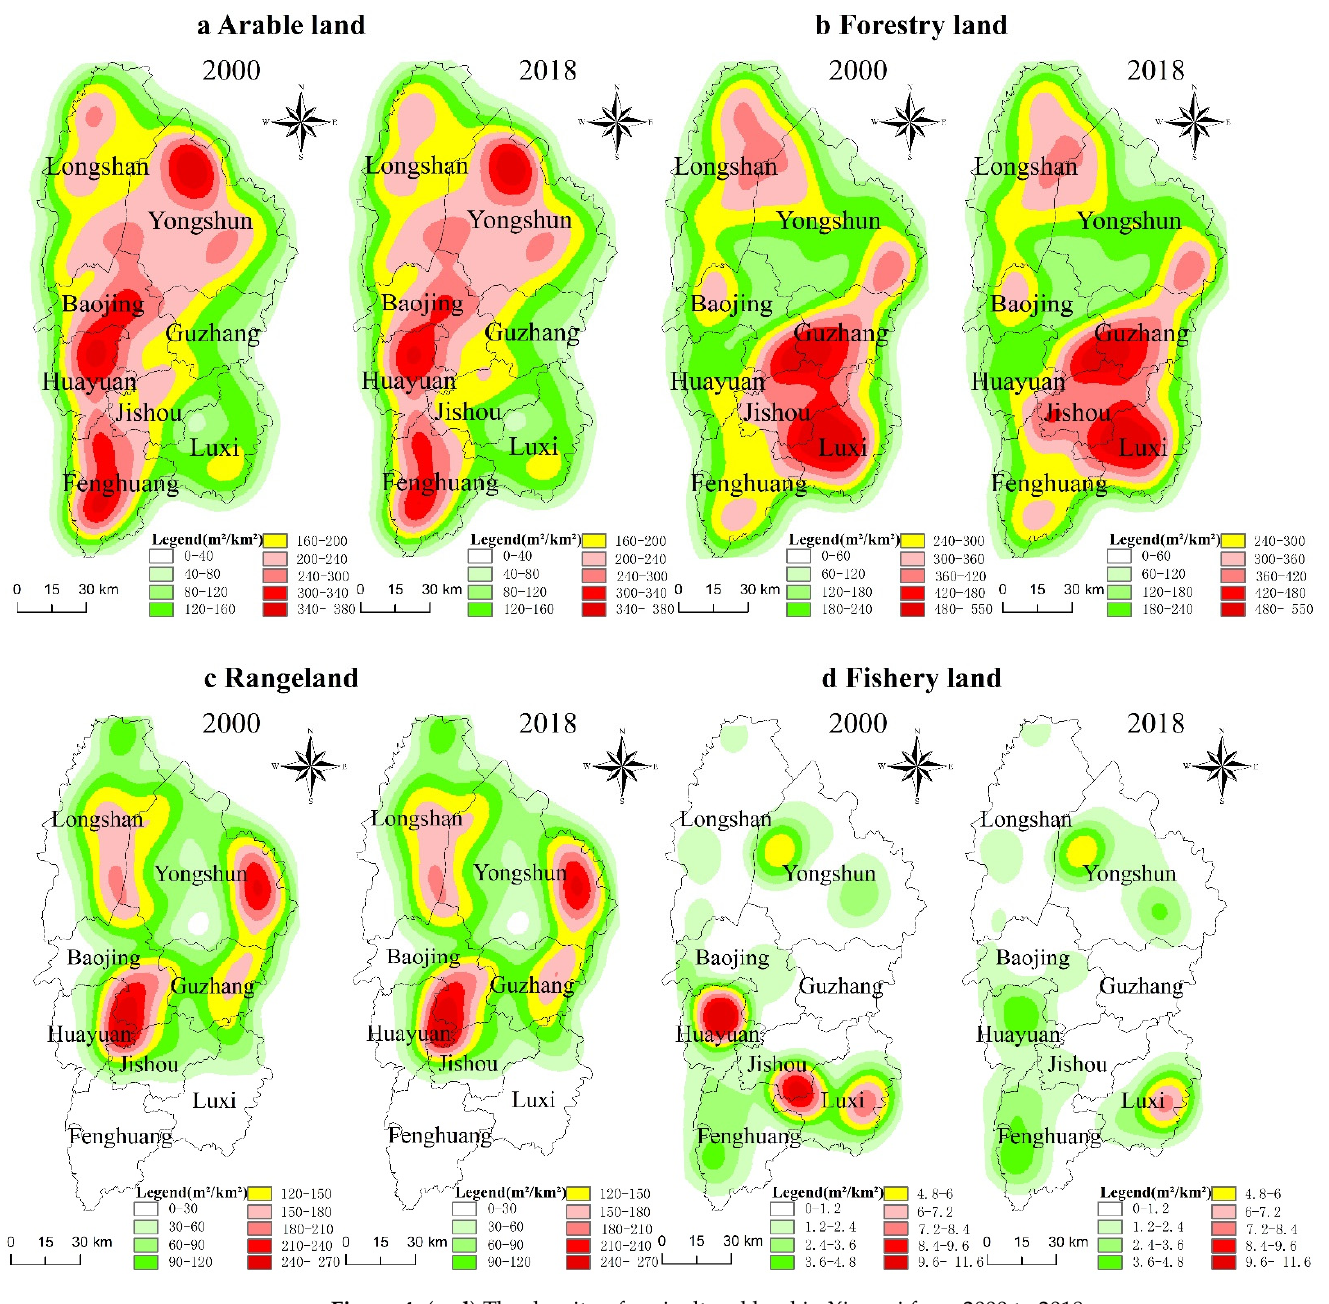
Figure 4. ( a – d ) The density of agricultural land in Xiangxi from 2000 to 2018. The gain of arable land was concentrated in the north, and Yongshun had the highest positive gain (62.95 km 2 ) (Figure 5a, Table 5). Nevertheless, the loss was concentrated in the south and north, and Yongshun also had the highest negative loss (75.17 km 2 ) (Figure 5a, Table 5). Arable land in all regions declined across the 18 years, and Jishou declined the most (20.55 km 2 ), while Huayuan declined the least (2.90 km 2 ). Yongshun and Jishou were the most frequently changing regions (consisting of 47.42% of total change), while Huayuan and Longshan were the least frequently changing regions (only consisting of 8.8%) (Table 5). In addition, the change rate ( N a ) and dynamic ( K d ) in Jishou were also higher than other areas. This showed that the problem of arable land occupation in Xiangxi could not be ignored, especially in the administrative center